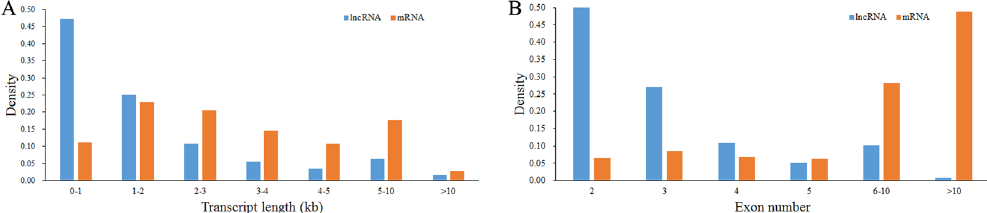
Figure 2. Genomic features of predicted lncRNAs. ( A ) Length distribution of lncRNAs and mRNAs. ( B ) Exon number distribution of lncRNAs and